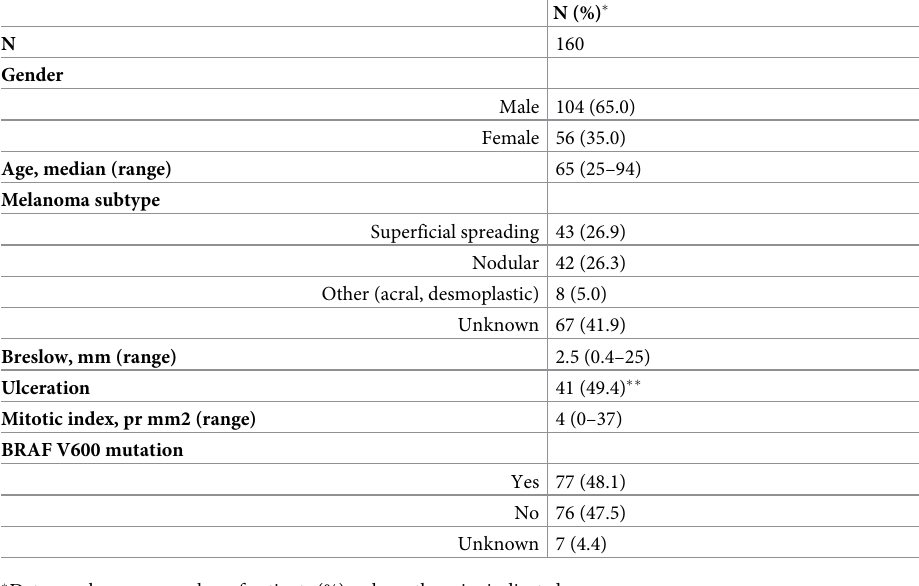
Table 1. Patient characteristics of the study population stage III